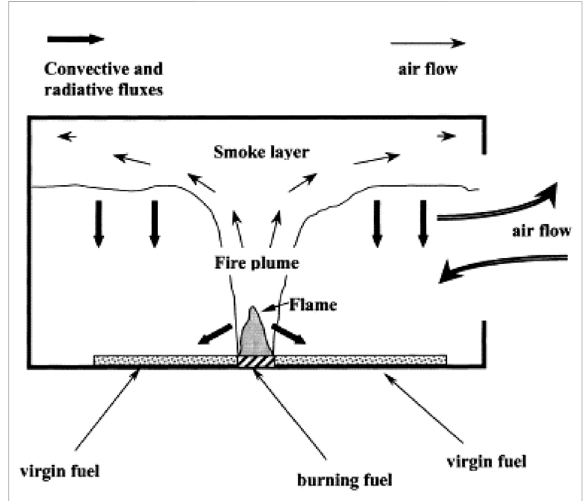
FIGURE 3 A typical schematic focused on fi res inside a con fi ned room or compartment (Novozhilov